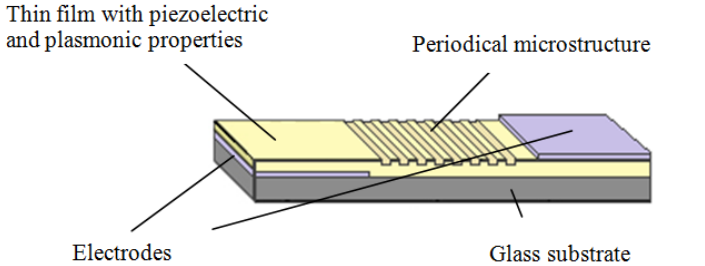
Figure 1. Active optical element based on piezoelectric and SPR